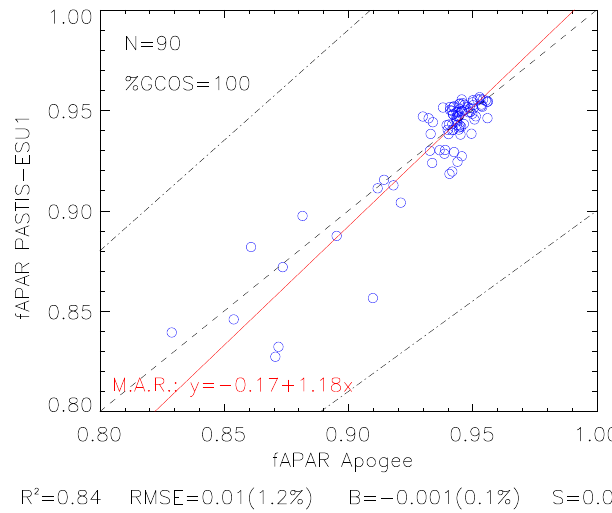
Figure 5. Correlation between fAPAR PASTIS-ESU1 and fAPAR APOGEE for Collelongo site in 2015 (DOY 139–300). Number of samples (N), Major Axis Regression (M.A.R.), correlation (R 2 value), RMSE, bias (B), standard deviation (S), and percentage of values matching the GCOS requirements (%GCOS) are displayed. Dashed lines correspond to the 1:1 line and GCOS uncertainty levels; the red continuous line corresponds to the M.A.R.